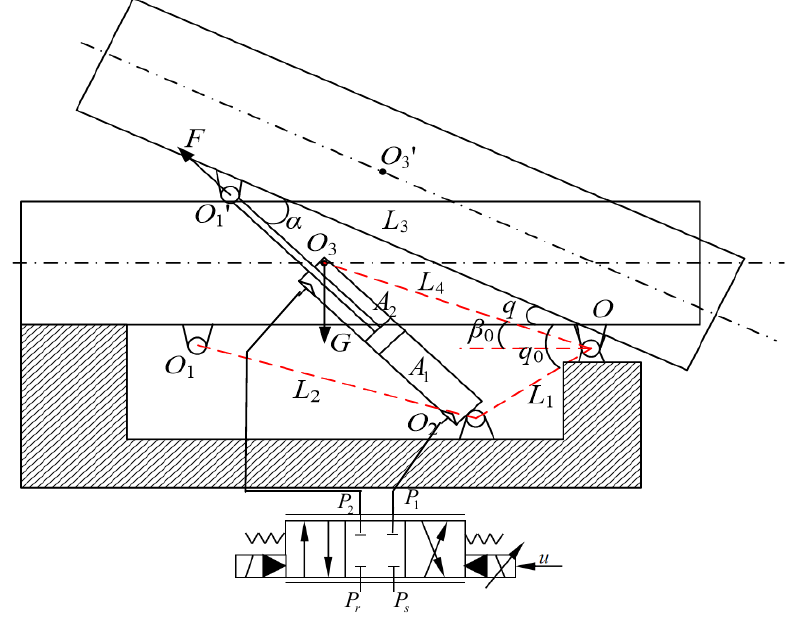
Figure 1. A sketch of the lifting system.